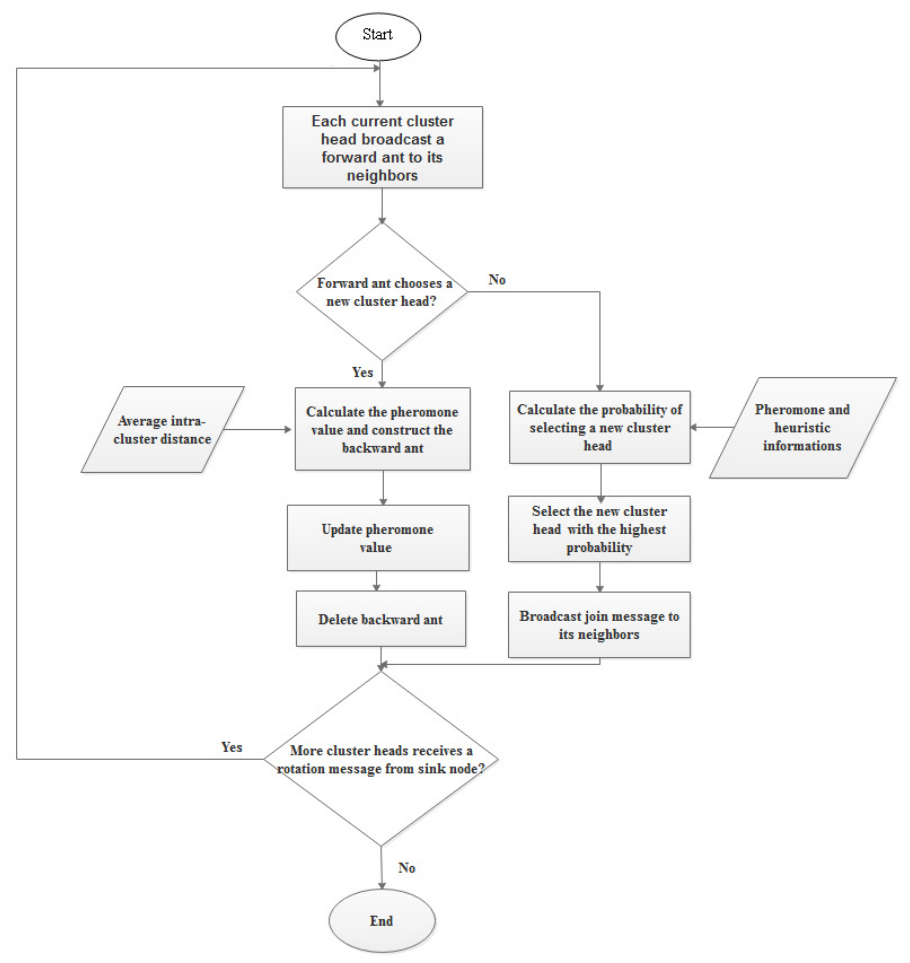
Figure 4. The proposed clustering algorithm flowchart.